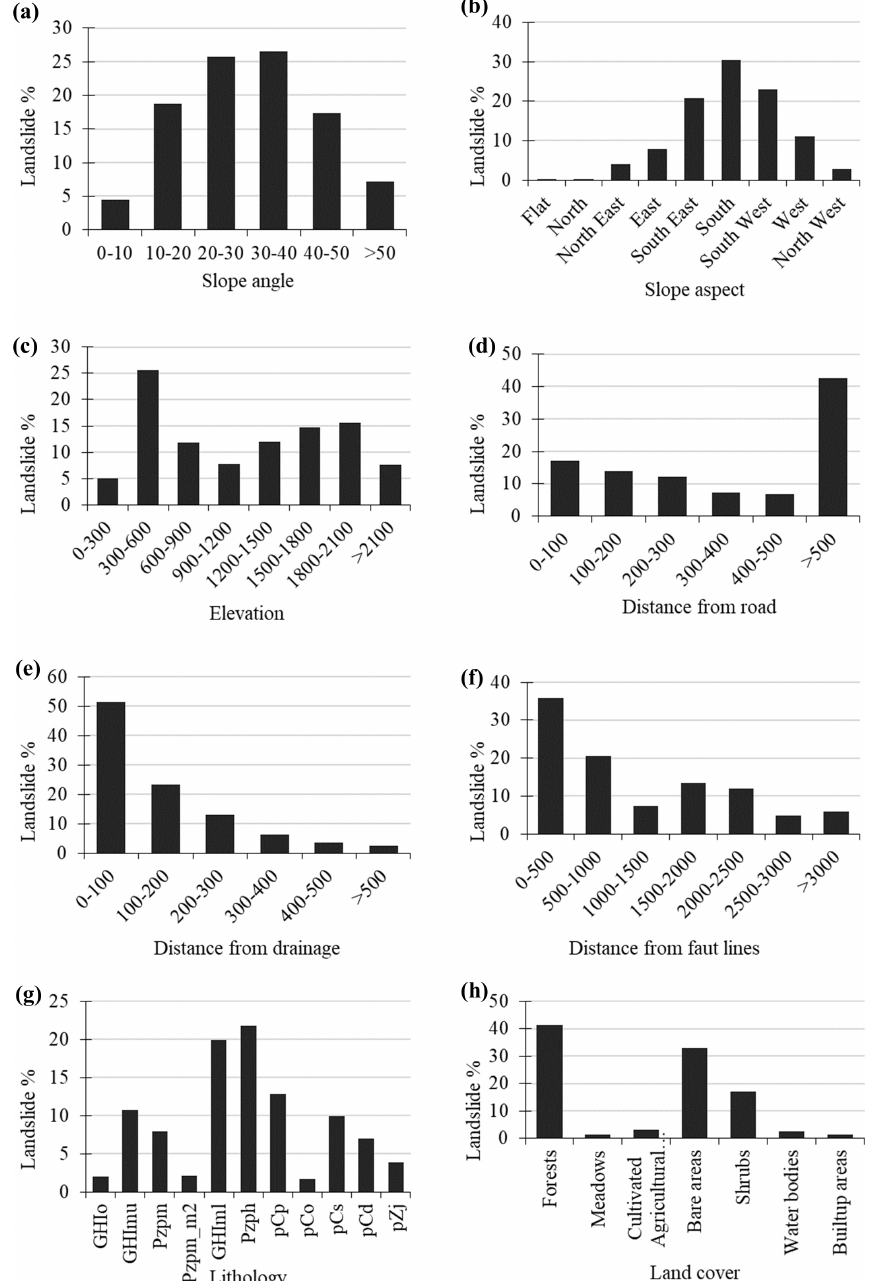
Figure 5. Percentage of landslides in each class of the causal factors of landslide occurrence: ( a ) slope angle, ( b ) slope aspect, ( c ) elevation, ( d ) distance to road, ( e ) distance to drainage, ( f ) distance to fault, ( g ) lithology, and ( h ) land